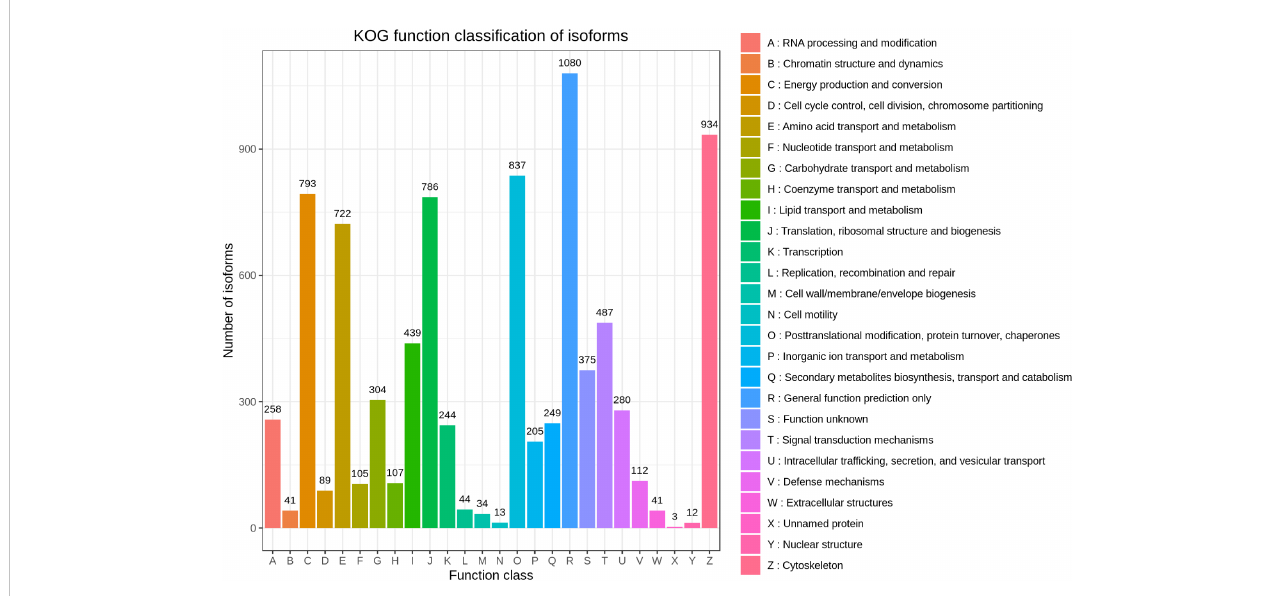
FIGURE 4 KOG annotation of H. cunea transcripts. The x-axis represents KOG categories; the y-axis represents the number of